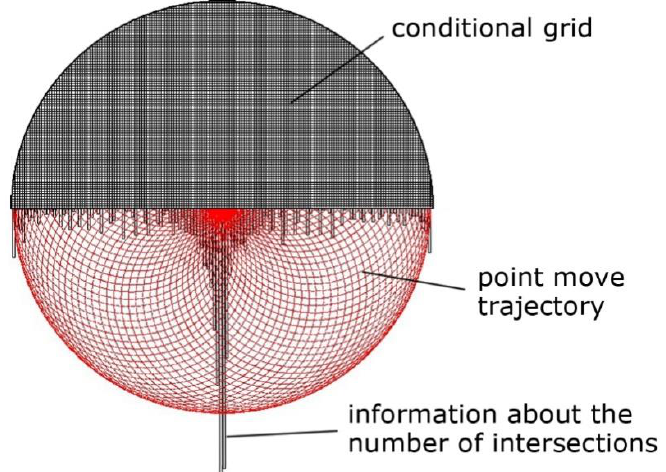
Figure 5. Accumulation of information about the number of intersections in conditional grid cells.